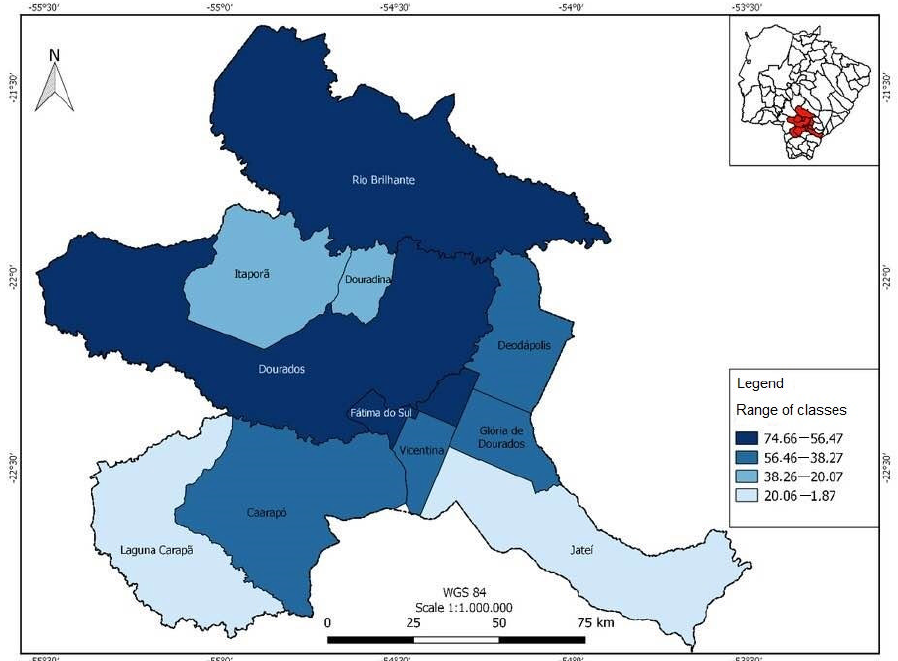
Figure 3. Kernel map indicating the spatial distribution of the frequency of micronuclei in the microregion of Dourados based on the range of classes.